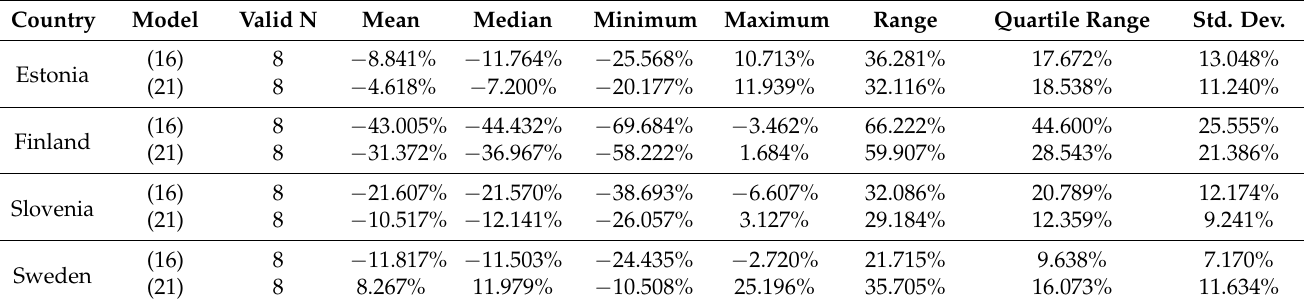
Table 8. Descriptive statistics of relative residuals of PRM (16) and nonlinear (21) models for “critical” EU